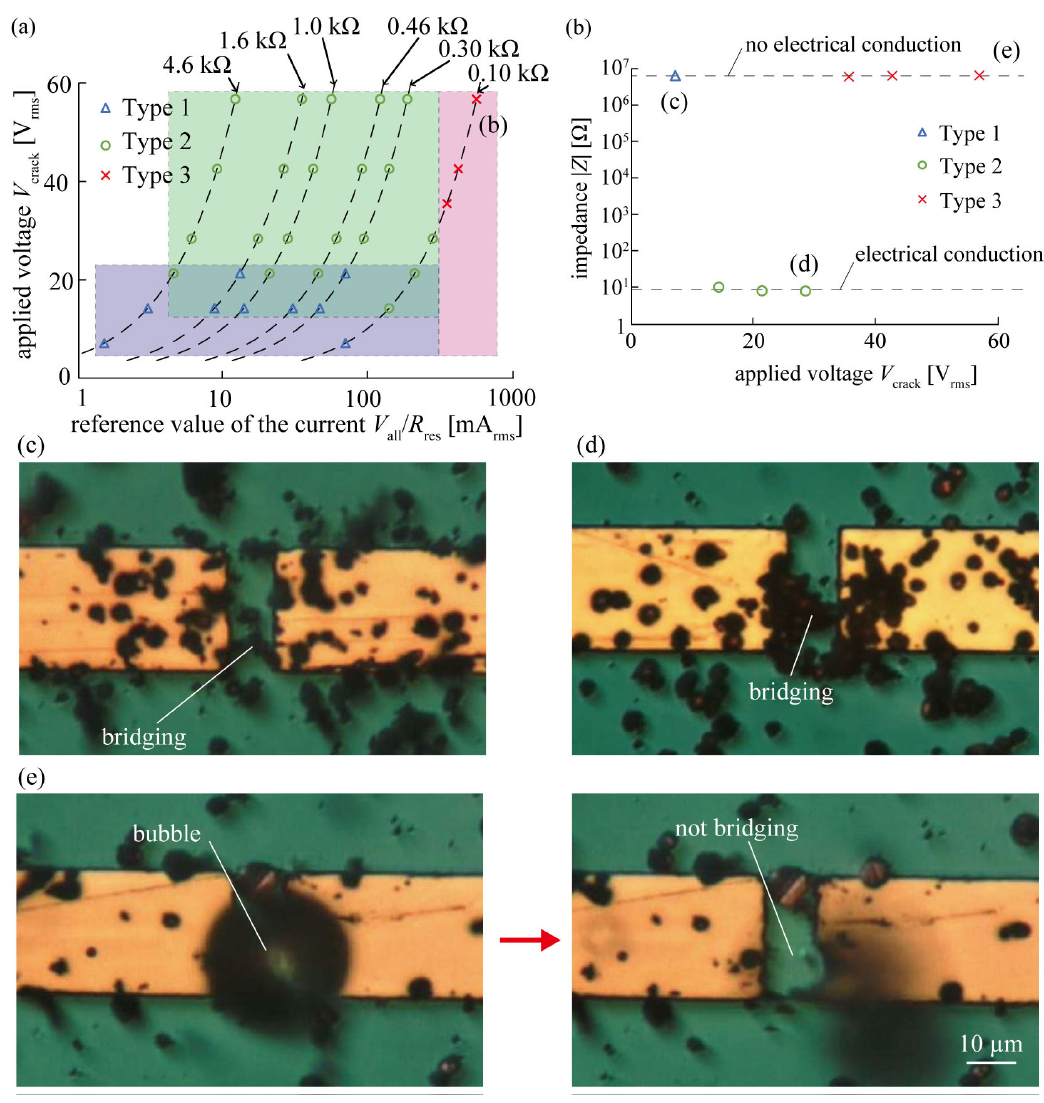
Figure 3. Classification of bridging and conduction morphology of copper microparticles. ( a ) Formation condition plot between applied voltage, V crack , and reference value of current, V all / R res . ( b ) Relationship between applied voltage and impedance after voltage application (0.10 k Ω ). ( c ) Metal interconnect at 7.1 V rms . ( d ) Metal interconnect at 28 V rms . ( e ) Metal interconnect at 57 V rms .